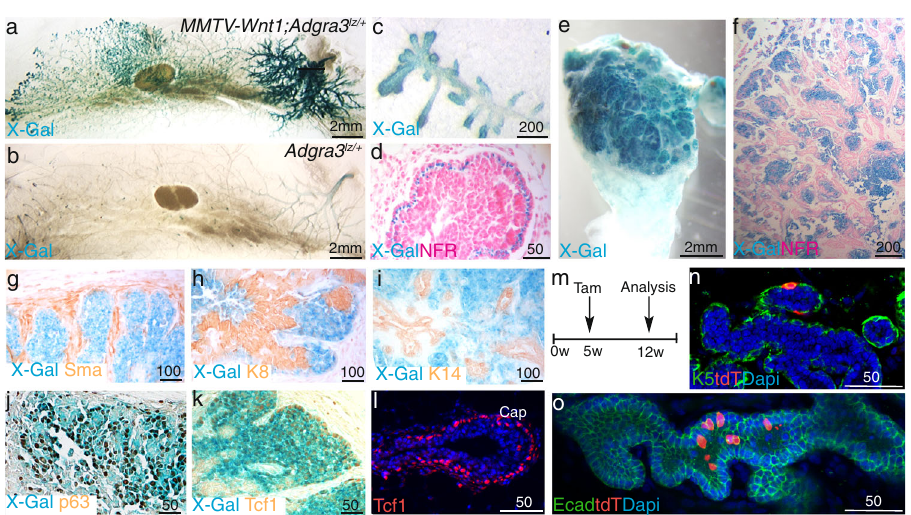
Fig. 6 Gpr125 + progenitors are expanded in MMTV-Wnt1 tumors and retain embryonic features and bipotency. a – c X-gal (blue) stained mammary whole mounts from 8-week-old MMTV-Wnt1;Adgra3 lz/ + mice ( n = 23 mice) show robust Gpr125- β -gal expression in hyperbranched ductal tips ( c ) and nipple-proximal zones compared to ( b ) control Adgra3 lz/ + littermate. d X-gal (blue) section of hyperbranched ductal tip counterstained with NFR presenting basal restriction of Gpr125- β -gal expression in 12-week-old MMTV-Wnt1;Adgra3 lz/ + mice. e - h X-gal (blue) stained whole mount and sections counterstained with NFR of MMTV-Wnt1;Adgra3 lz/ + tumor ( g – k ) showing Gpr125 cells devoid of immunolocalization (brown) for SMA, K14 or K8, but expressing p63 and Tcf1 ( n = 4 tumors/marker). l Tcf1 expression (red) in the cap cells of normal TEB ( n = 3 mice). m – o Lineage tracing strategy in 5- week-old MMTV-Wnt1;Adgra3 lz/ + produced both ( n ) K5 + (green) and ( o ) Ecad + ;tdT + (green/red) cells in hyperplastic glands at 12 weeks. DAPI = blue nuclear staining. One gland from each of the fi ve mice were